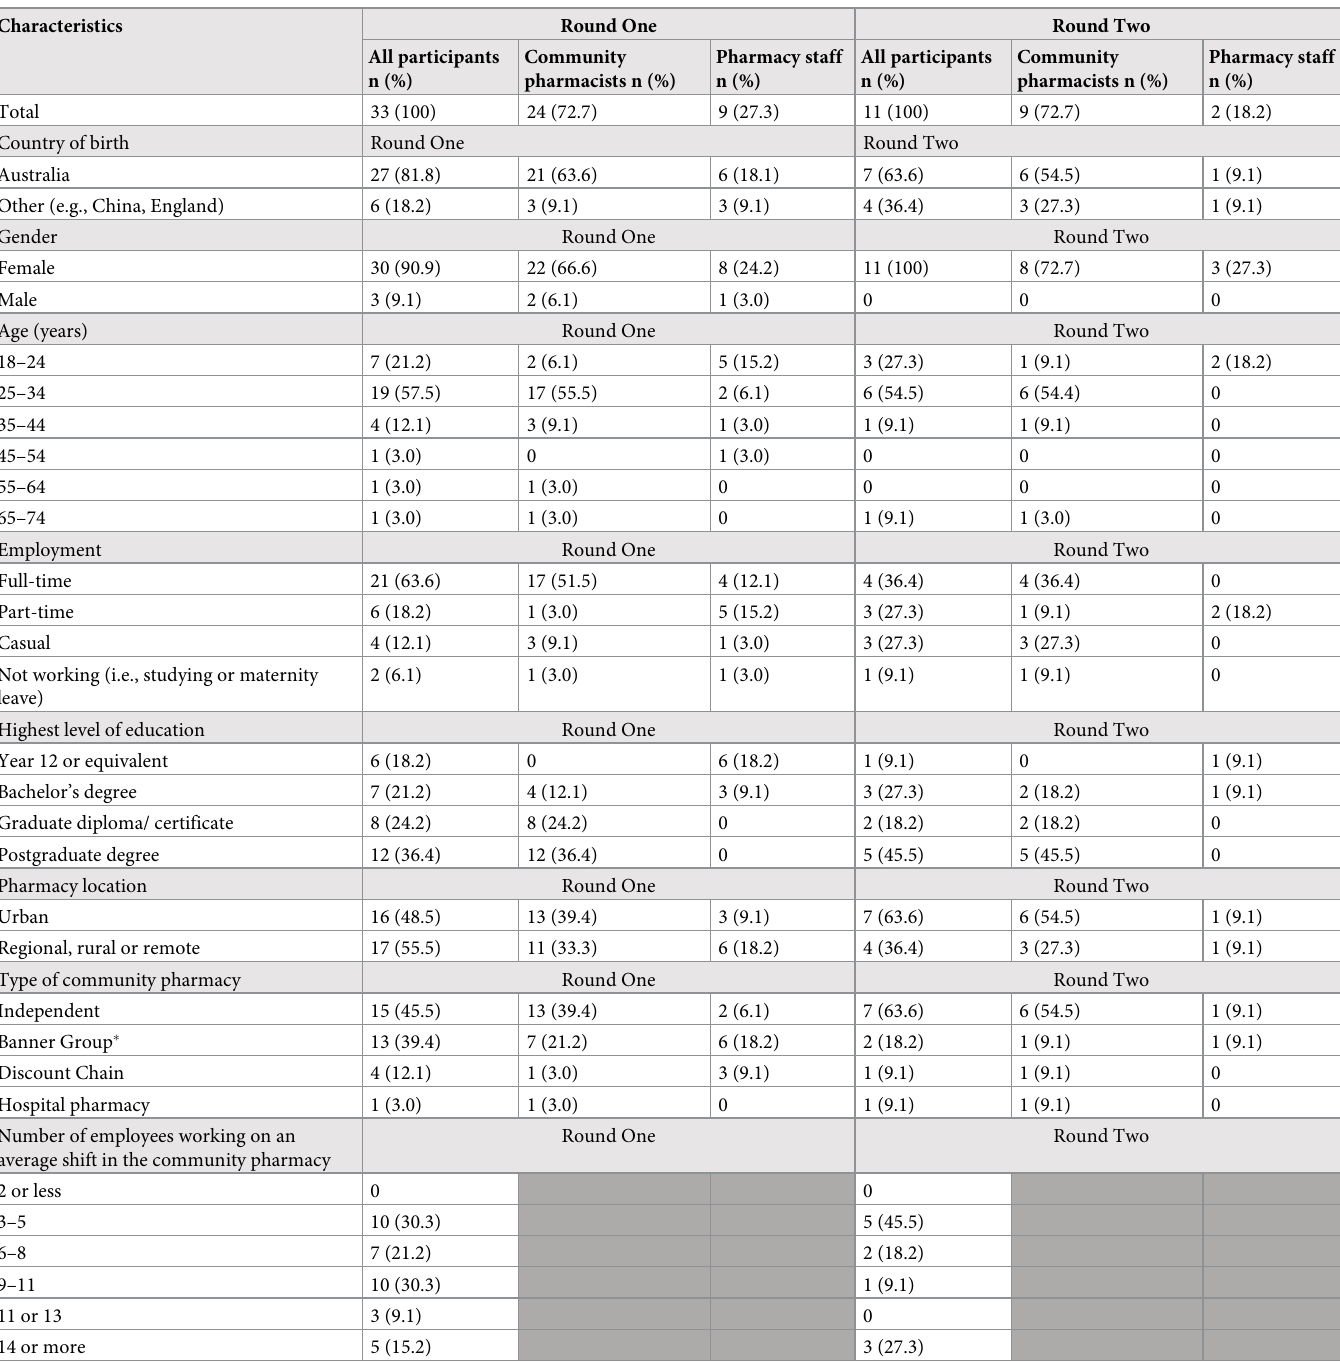
Table 2. Participants’ demographics (Rounds One and